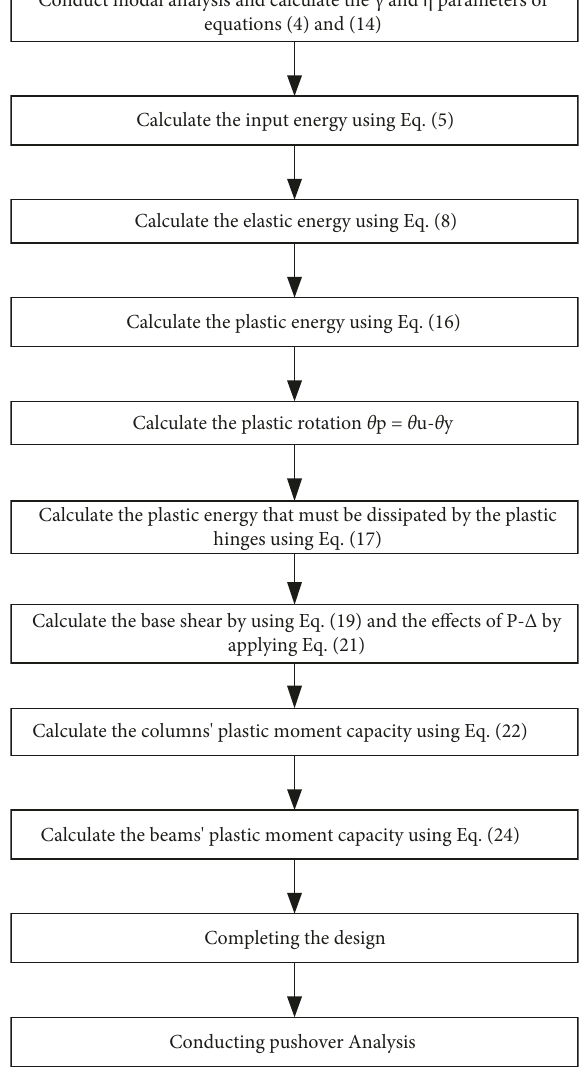
Figure 9: Flowchart of the modified energy